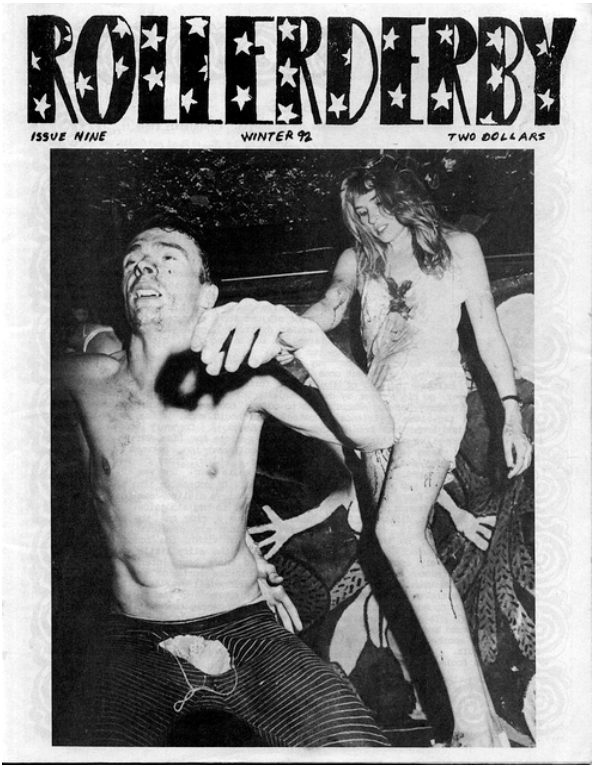
Figure 18. Jean-Louis Costes and Dame Darcy , on the cover of Rollerderby , n° 9, winter 1992.